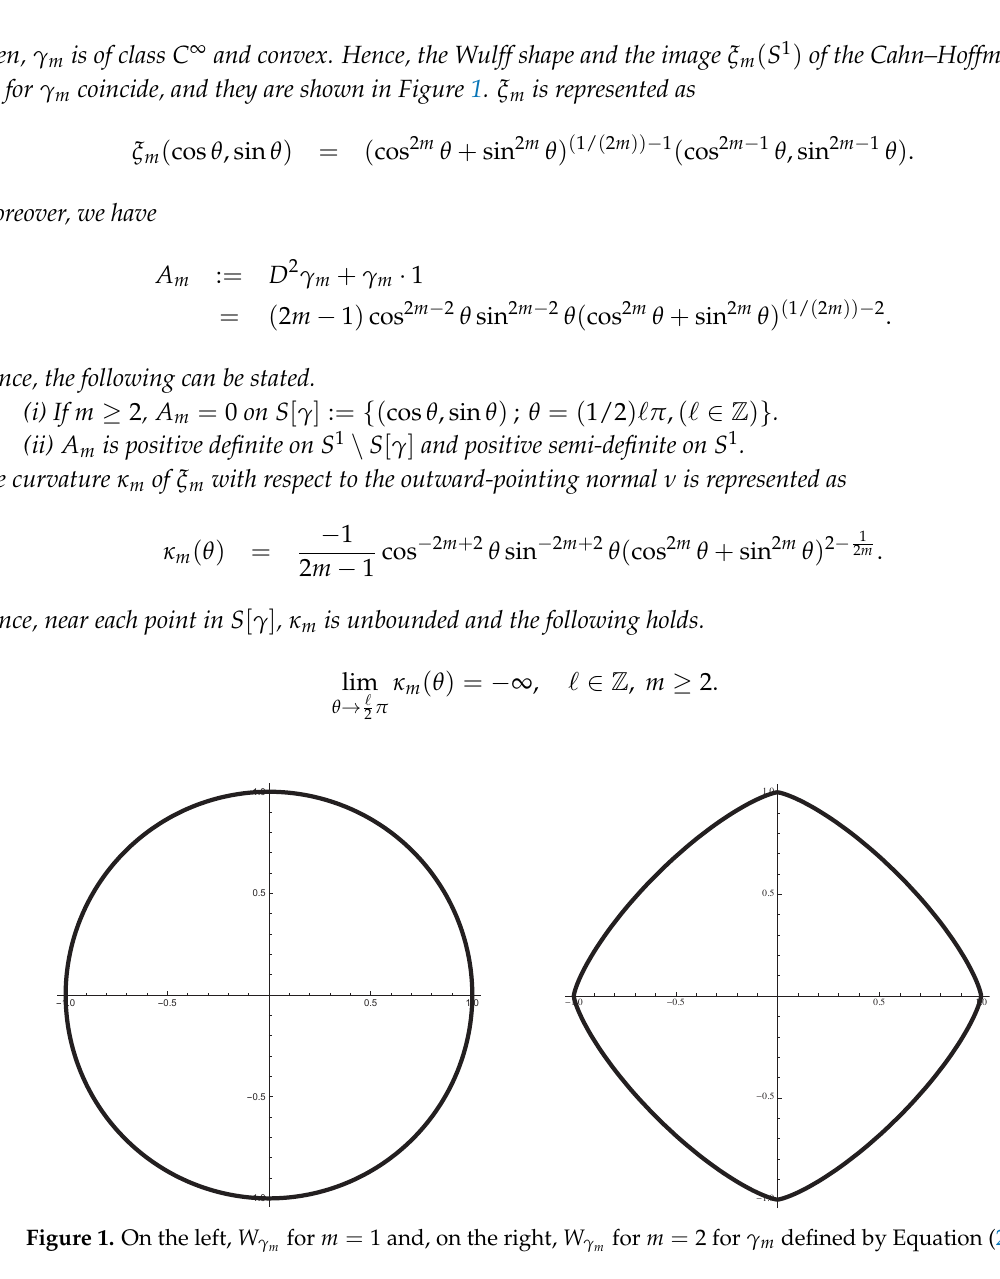
for m = 2 for γ m defined by Equation m